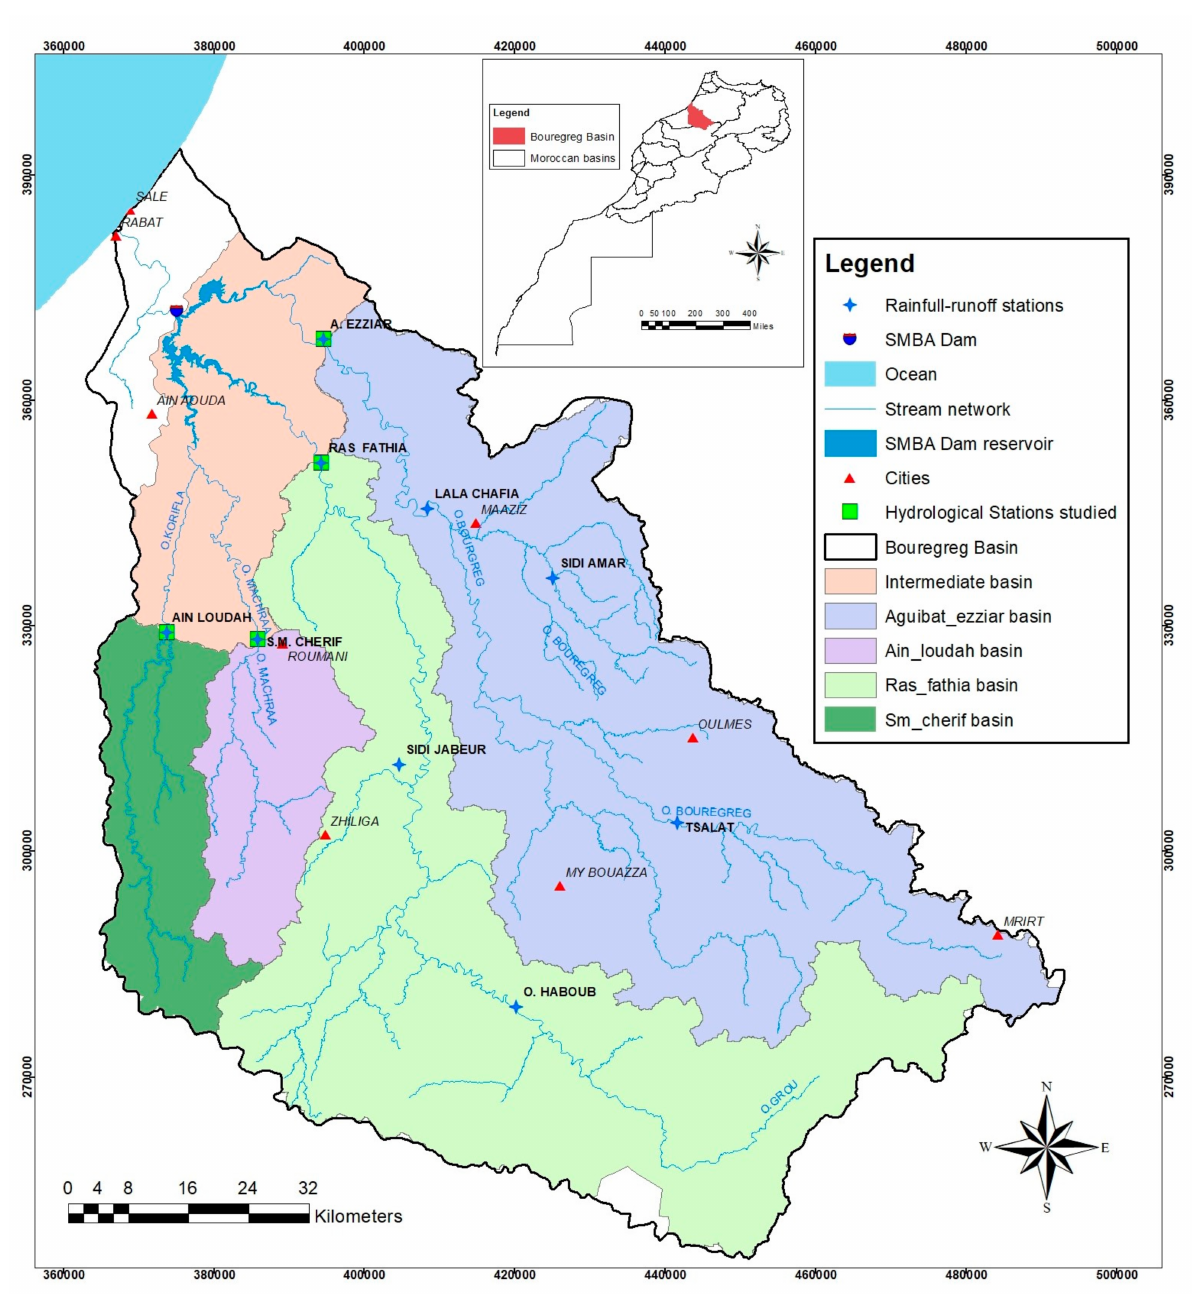
Figure 1. Study area location in